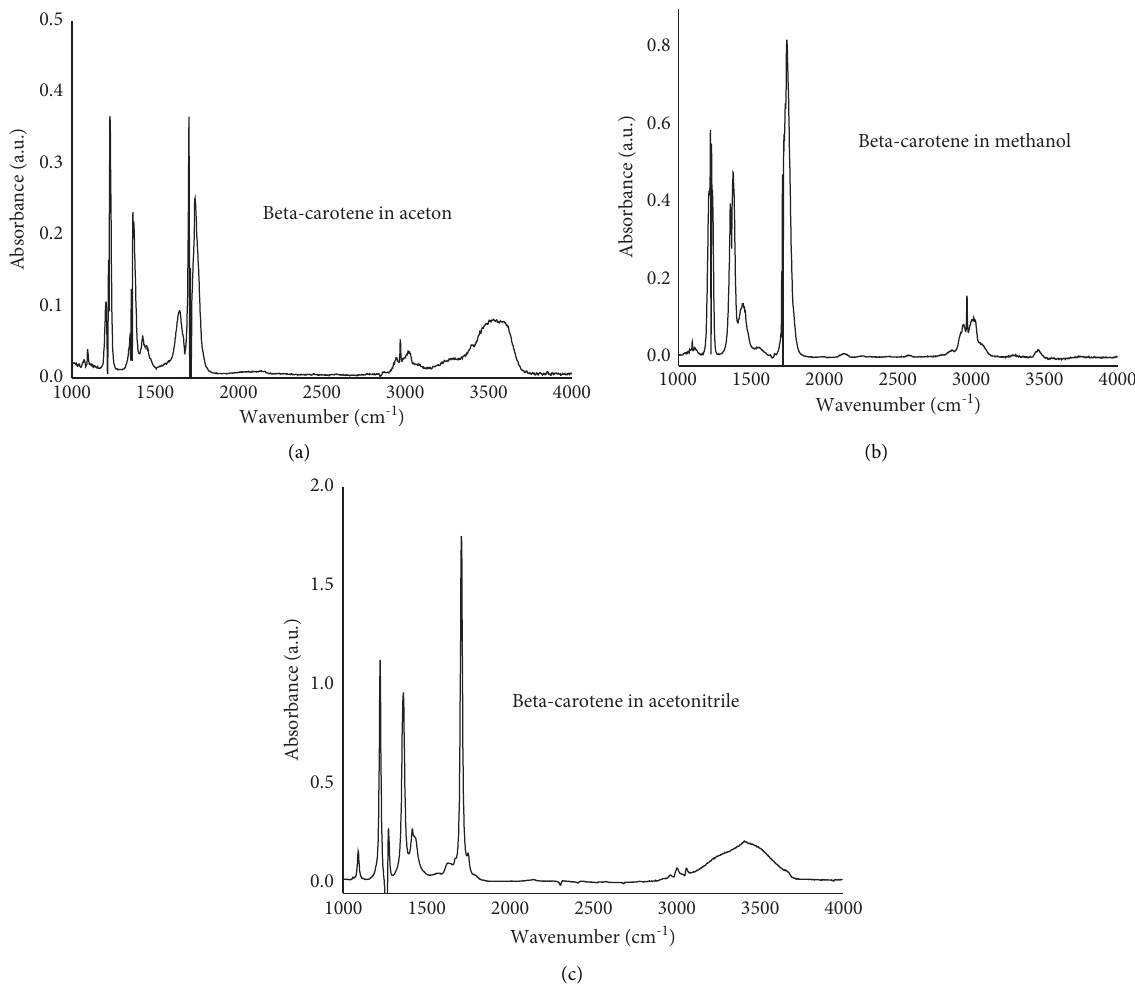
Figure 8: FTIR-ATR spectra of β -carotene in acetone (a), methanol (b), and acetonitrile (c).